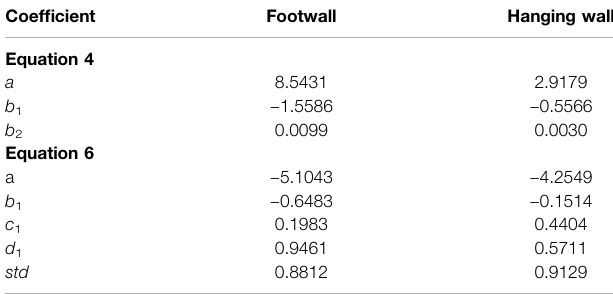
TABLE 2 | Coef fi cients for Eqs 4 and 6 .